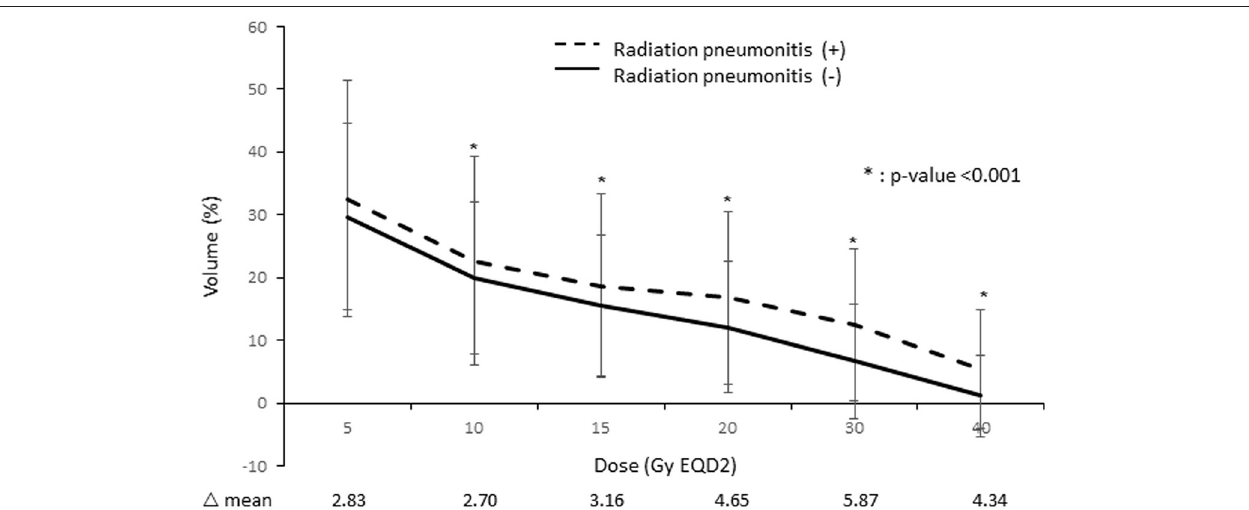
Frontiers in Oncology |